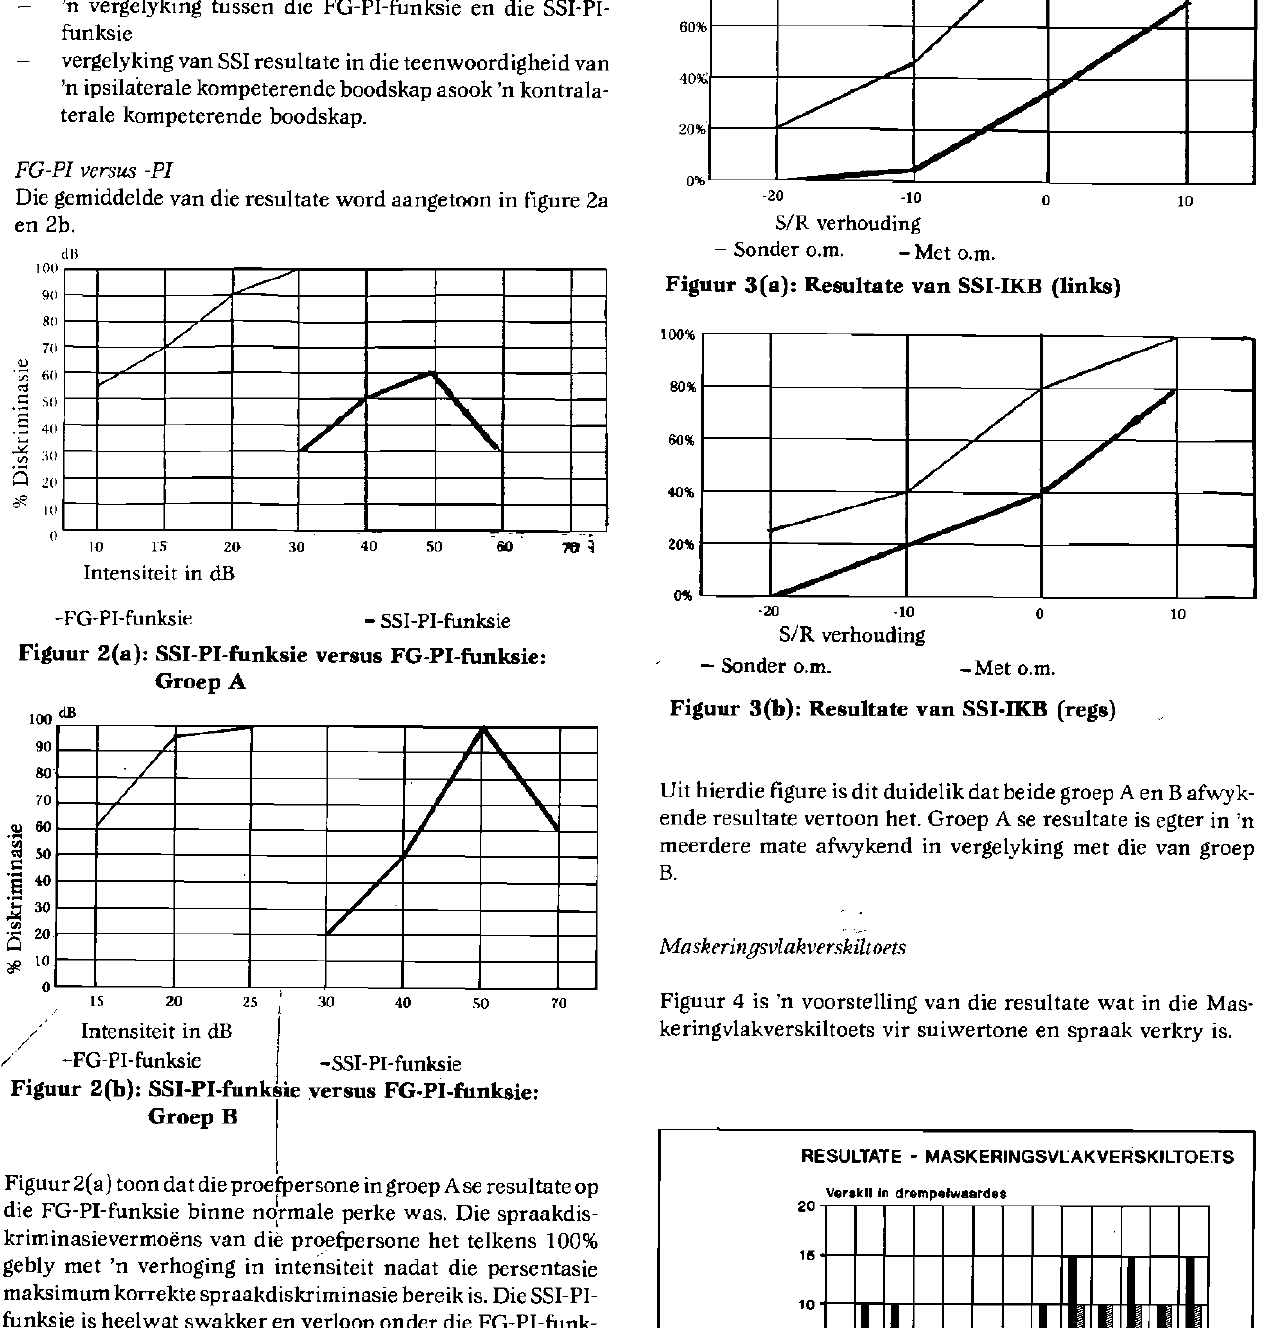
Figuur 2(a) toon dat die proefpersone in groep A se resultate op